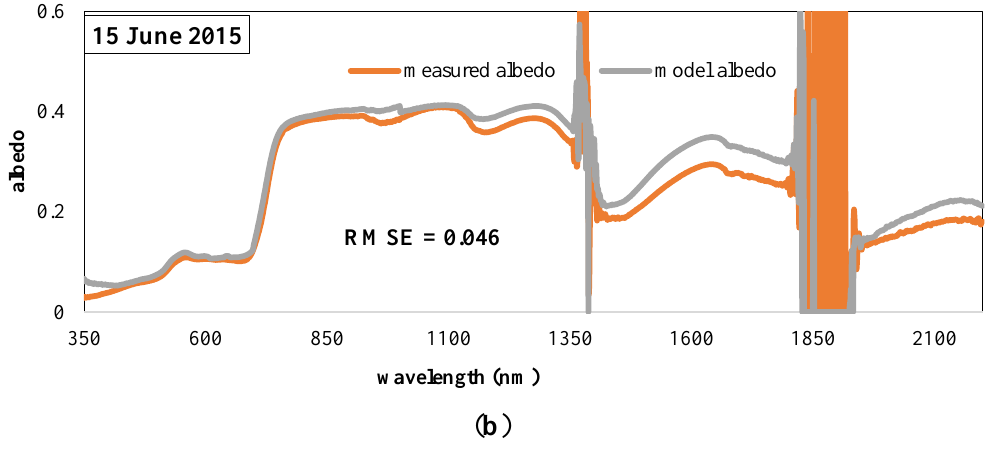
Figure 19. Comparison between the measured spectral albedo and model-simulated albedo on ( a ) 30 May and ( b ) 15 June.